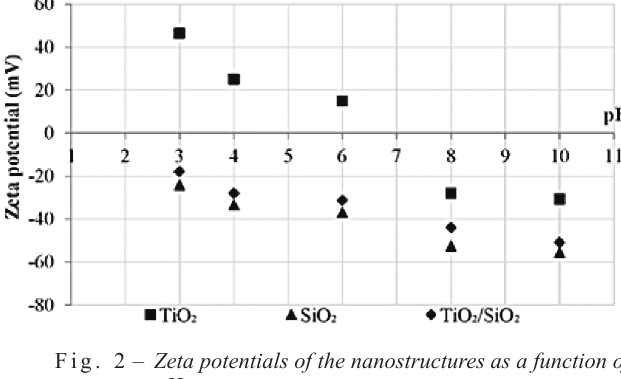
Fig. 2 – Zeta potentials of the nanostructures as a function of